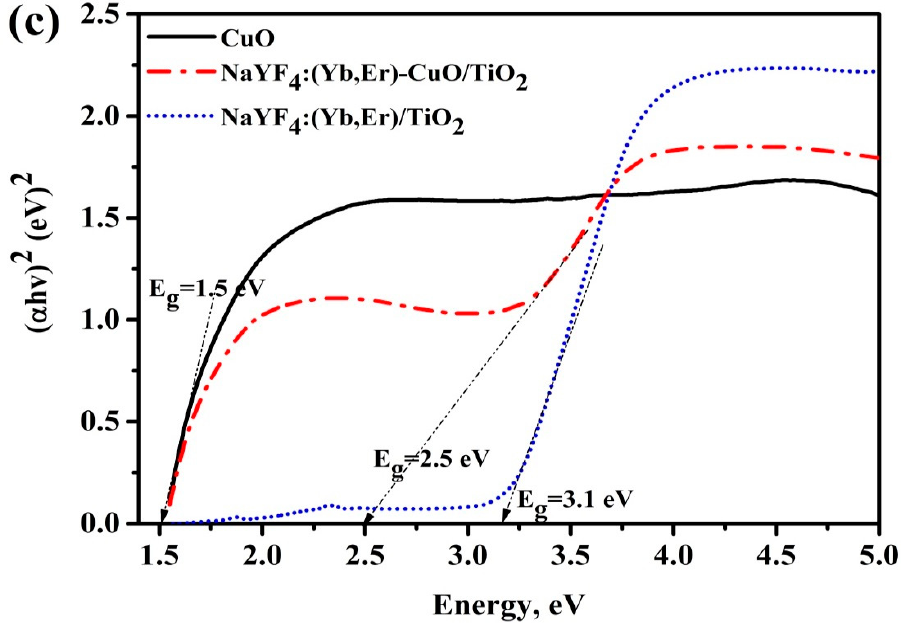
Figure 4. UV-vis diffuse reflectance spectra for ( a ) NaYF 4 :(Yb,Er), CuO and NaYF 4 :(Yb,Er)-CuO/TiO 2 composite; ( b ) enlargement spectra at 350–700 nm wavelength axis in ( a ) and ( c ) Kubelka-Munk plots with the band gap energies.